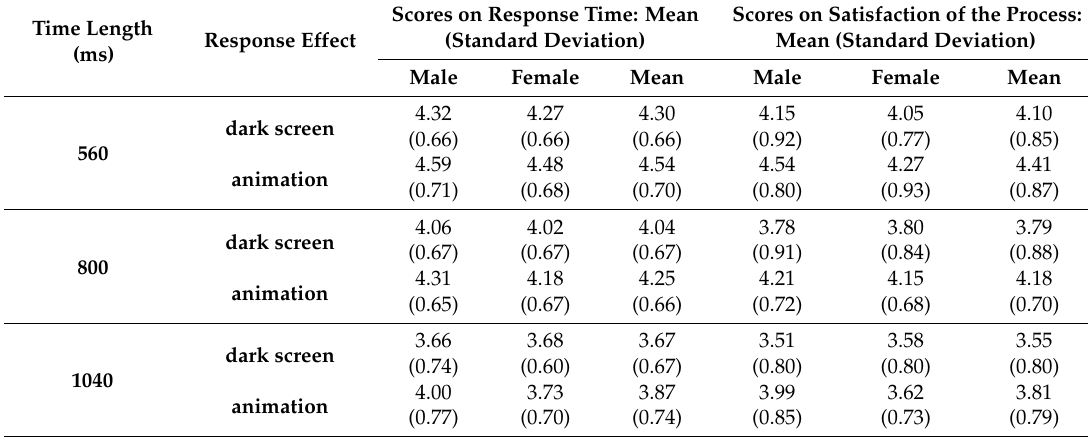
Table 1. Specified scores for the scenario of initialization of dialer.